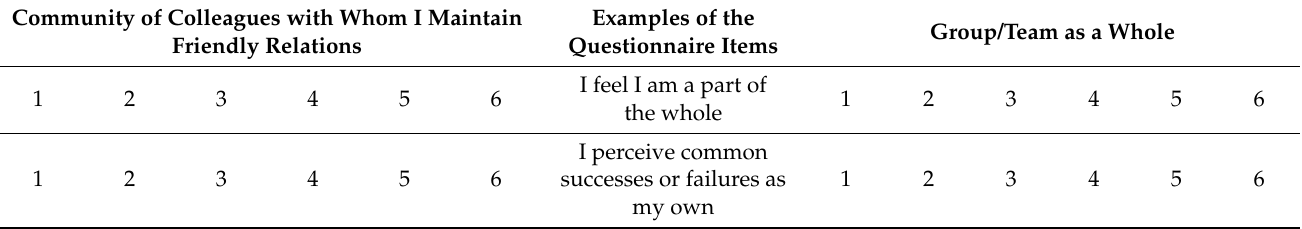
Table A1. Micro-group Identification Questionnaire